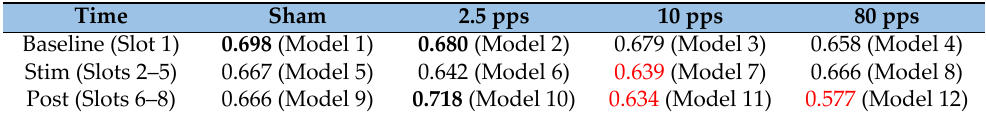
Table 8. Confusion matrix results ( kappa ) for the 12 models in Phase 3. Values in bold are in the upper quartile of all 16 values, and those in red in the lower quartile.